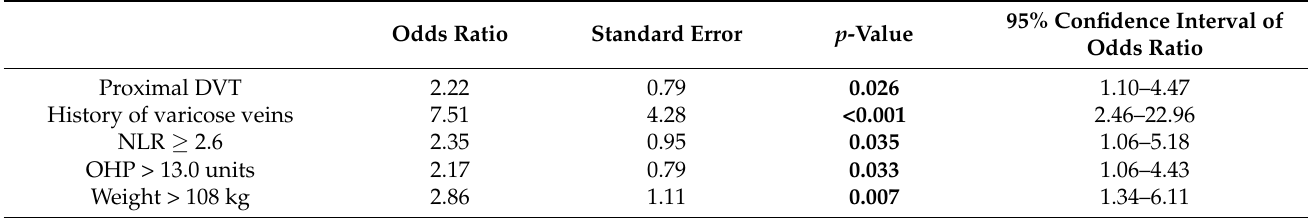
Table 4. Multivariate logistic model for prediction of developing post-thrombotic